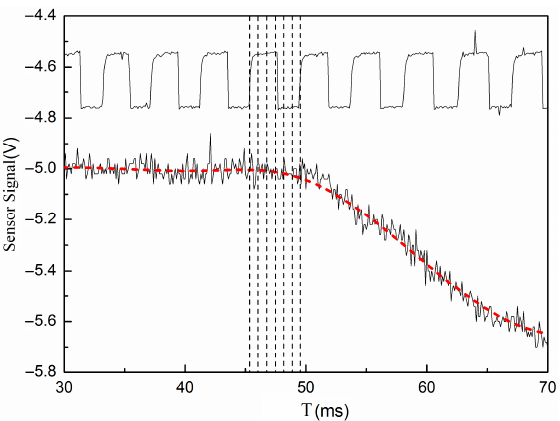
Figure 3. Lift and camshaft angle signals near the valve opening time.